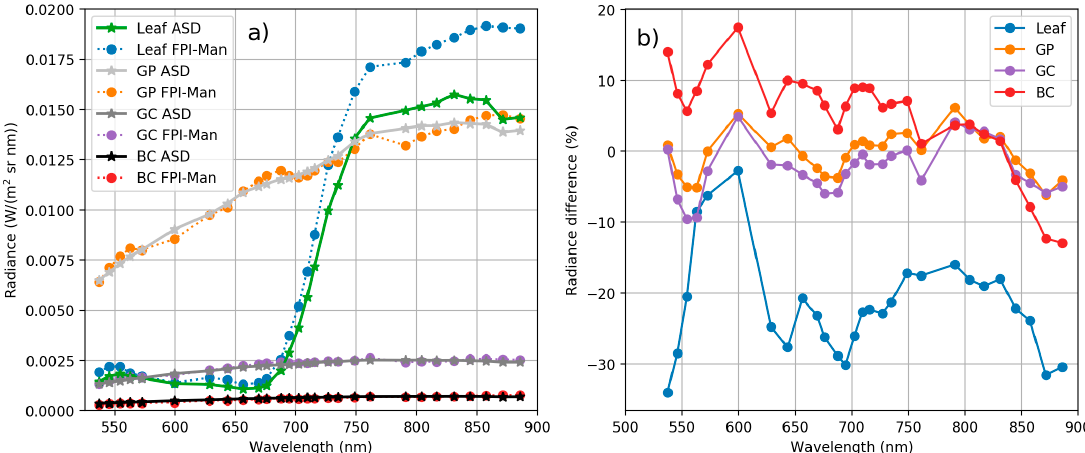
Figure 7. ( a ) Radiance spectra of reference panels BC, GC, GP and leaf measured with FPI camera based on manufacturer’s calibration (FPI-Man) and measured with ASD spectrometer. ASD spectra has been integrated to match FPI camera spectral responses. ( b ) Percentage difference between ASD and FPI L man radiance. Stable FPI bands only.